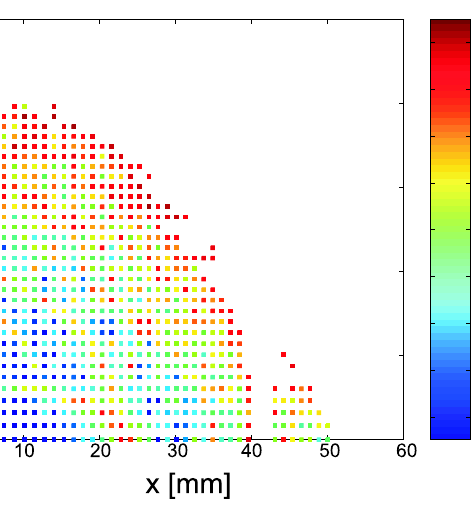
FIG. 13. (Color) Optimized dynamic aperture with harmonic sextupoles (with errors), for the mode with momentum compac- tion 2 (cid:1) 10 (cid:2) 4